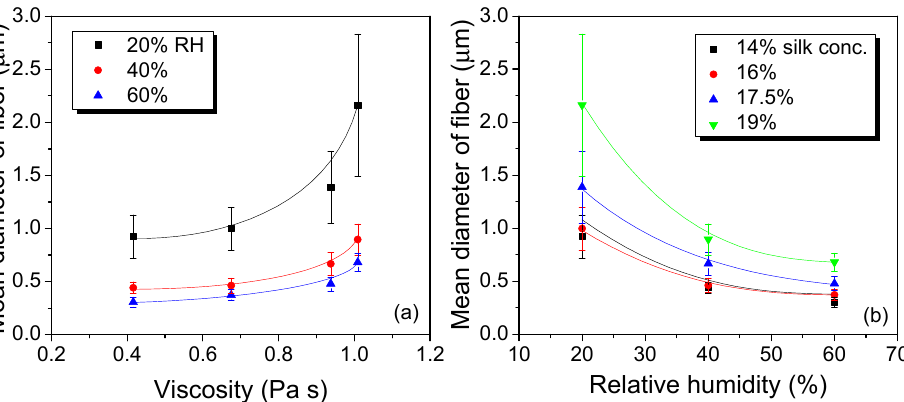
Figure 3. Effect of viscosity ( a ) and relative humidity ( b ) on the mean diameter of electrospun regenerated silk fiber ( n = 30). The error bars represent the standard